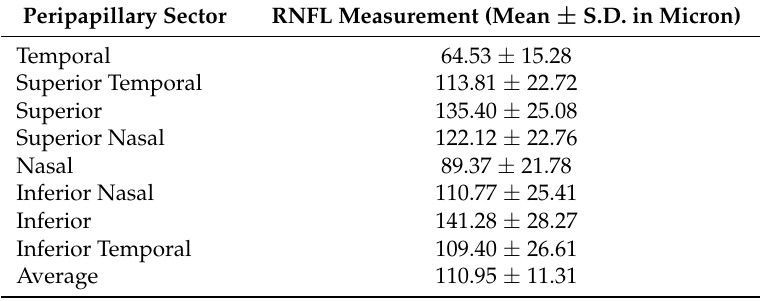
Table 2. Mean peripapillary RNFL measurements by Spectral-domain OCT of the 43 eyes (43 patients).